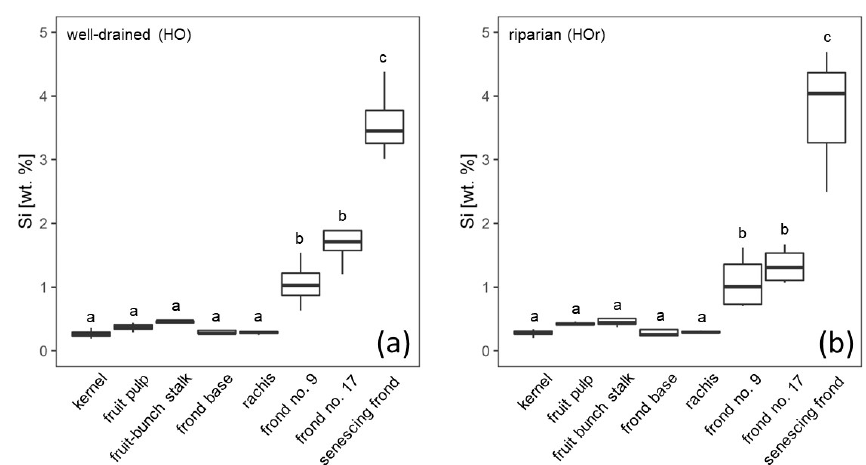
Figure 2. Si concentrations in oil-palm sub-parts at (a) well-drained and (b) riparian sites. Lower-cased letters indicate significant differences ( p ≤ 0 . 05) between oil-palm sub-parts within the same water regime. n = 4 for each plant part, except for the senescing frond and rachis, which is n = 3 at riparian sites.